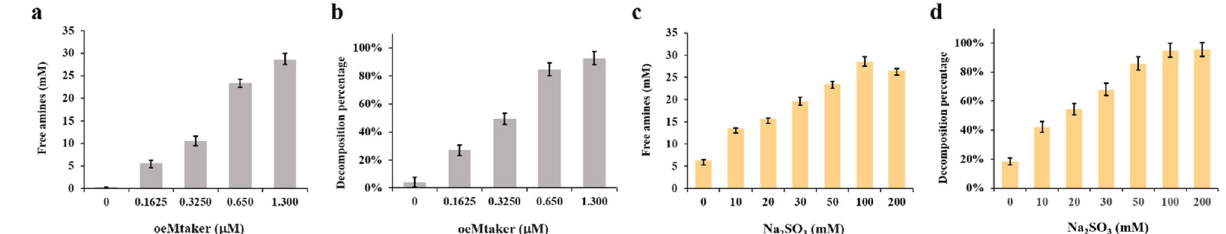
Figure 1. Dose dependent of keratinase (oeMtaker) and sodium sulfite (Na 2 SO 3 ) in ESM decomposition assays. The concentration of free amines ( a ) and decomposition percentage ( b ) in the ESM enzymatic hydrolysate (ESM-EH) was each measured at fixed concentration of 50 mM sodium sulfite. The quantified free amine ( c ) and decomposition percentage ( d ) in the ESM-EH when the reaction contained 0.65 μM of oeMtaker. Reactions were incubated at 55 °C for 3 h in a 1000 rpm orbital shaker. All data were obtained and averaged from at least three independent